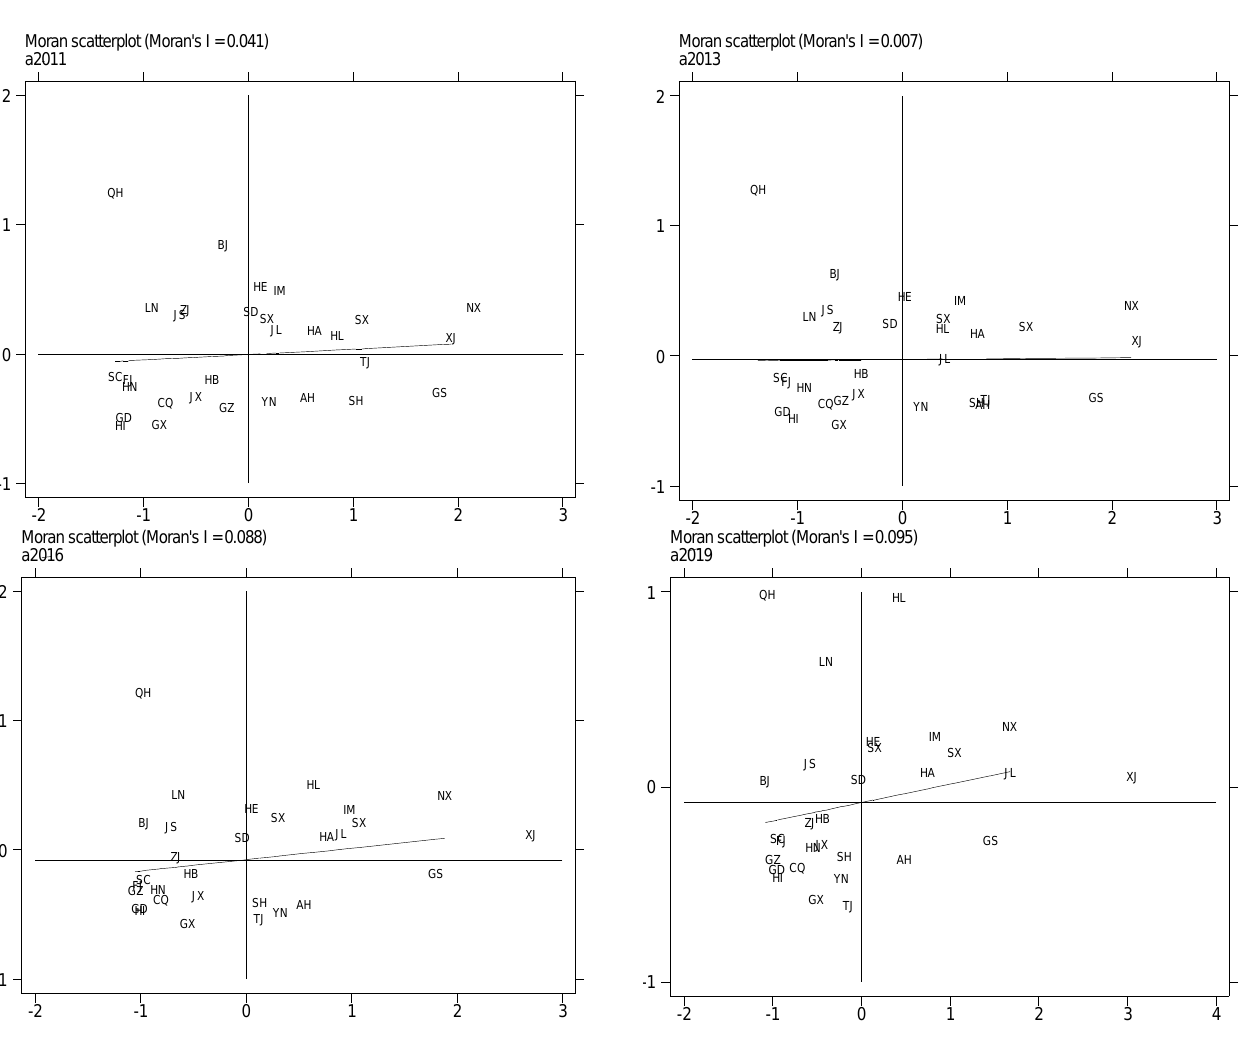
Figure 3. Moran scatter plots of agricultural carbon intensity in China for 2011, 2013, 2016, and 2019. Table 7. LM test, Wald test, Hausman test, and LR test